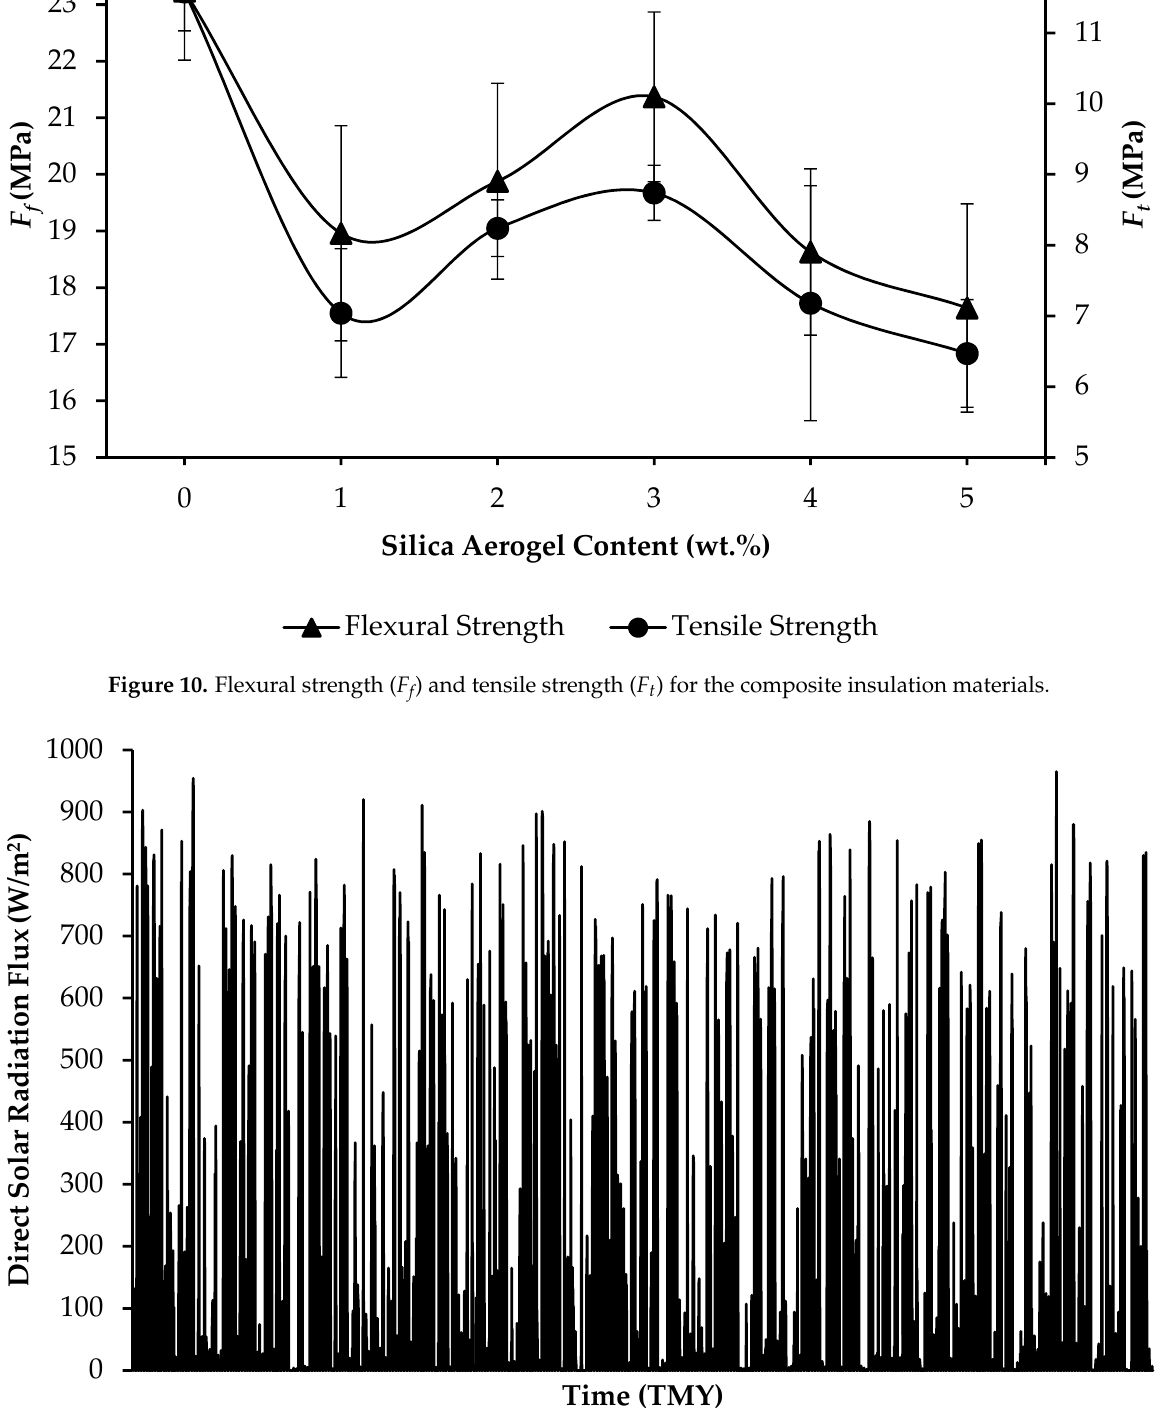
Figure 11. Direct solar radiation flux throughout the Typical Meteorological Year (TMY) at the location of the BIM.